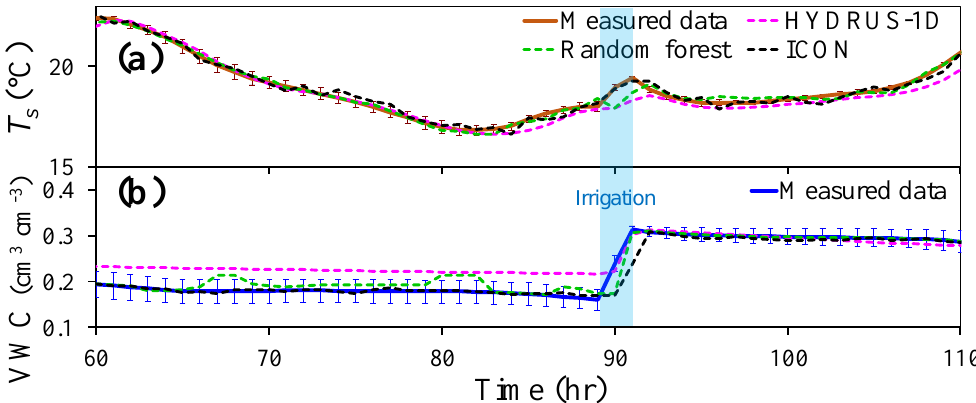
Figure 12. Simulation performance of models (HYDRUS-1D, random forest model, and ICON model) as compared to the measured data with error bars for ( a ) soil temperature and ( b ) volumetric water content. Error bars represent the standard deviation of the measured data.